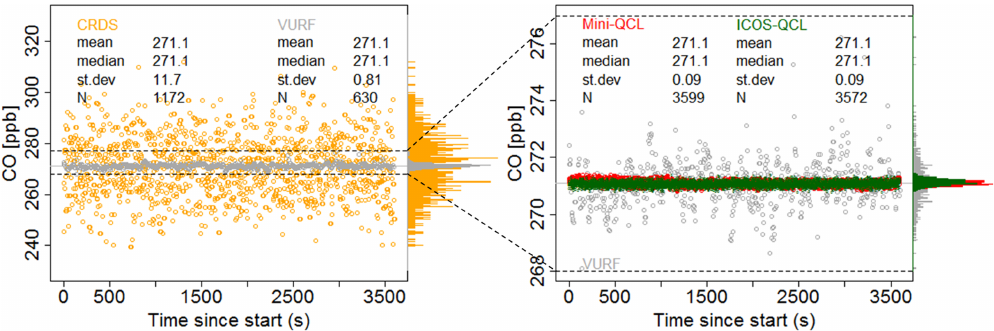
Fig. 1. Instrumental precision (noise) over a 1-h period for the highest possible time resolution (CRDS and VURF, 3.1s and 5.7s, left panel) and 1-s data (Mini-QCL and ICOS-QCL, right panel). The frequency distribution of individual measurement values is shown as a histogram on the right of each plot. The black dashed lines illustrate the different y-axis scales, and the VURF data (grey) are also shown in the right